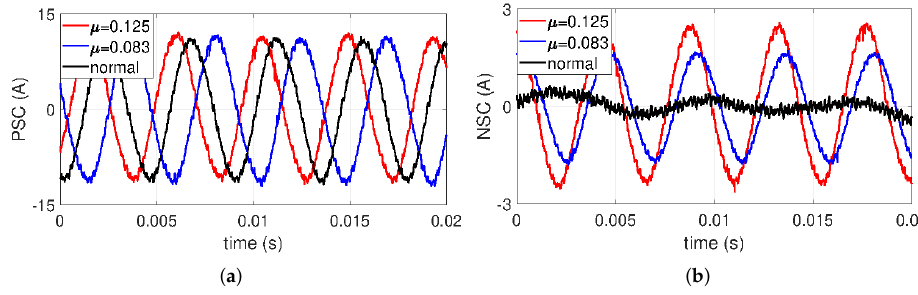
Figure 8. ( a ) PSC and ( b ) NSC with µ at rated